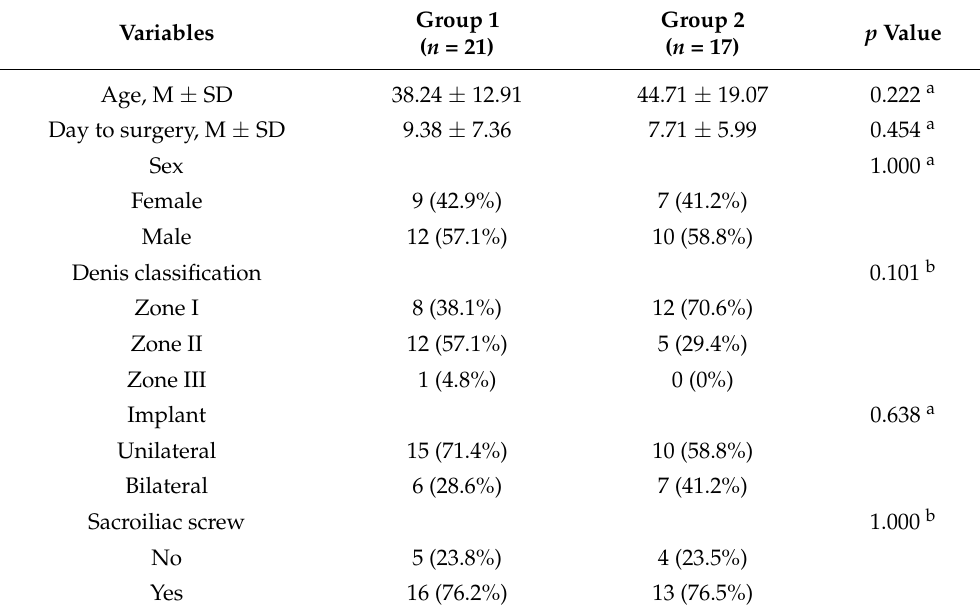
Table 1. Patients’ demographic data.